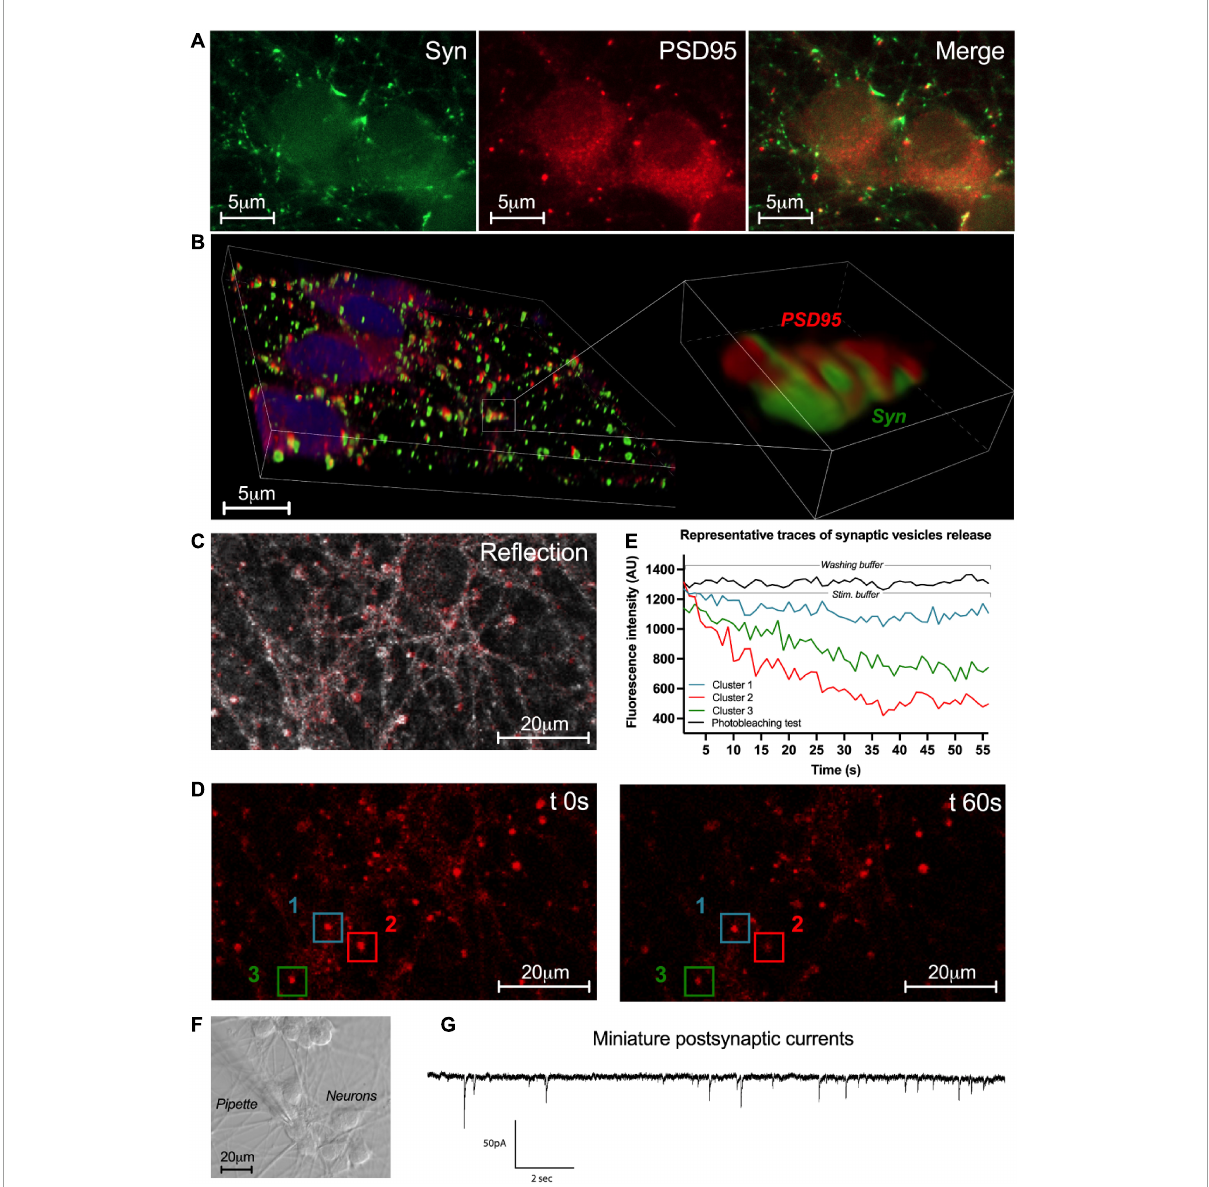
FIGURE6 Synaptic network activity of enteric neurons. (A) Double immunostaining of enteric neurons at D7 with the pre-synaptic marker synapsin I (Syn; green) and the post-synaptic marker PSD95 (red) ( n = 3 culture wells from 3 independent rat embryos). (B) 3D reconstructed confocal microscopy images of cultured neurons immunolabeleled for synapsin 1 (green) and PSD95 (red) with a higher magnification of the boxed region. (C) Representative image of the enteric neuron culture in reflection microscopy. (D) Fluorescence images of a field containing clusters measured at t 0s and t 60s after KCl stimulation. (E) Plot of FM1-43 fluorescence intensity analyzed from a representative cluster recorded in washing buffer and 3 representative clusters recorded in stimulation buffer of the enteric neuron culture at D7 (154 clusters analyzed from n = 3 culture wells from 3 independent rat embryos). (F) Representative image of enteric neurons in light microscopy and the patch clamp pipette used for the whole-cell configuration. (G) Representative trace of miniature post-synaptic currents (mPSCs) recorded from enteric neurons at D7 (10 neurons analyzed from n = 5 culture wells from 5 independent rat